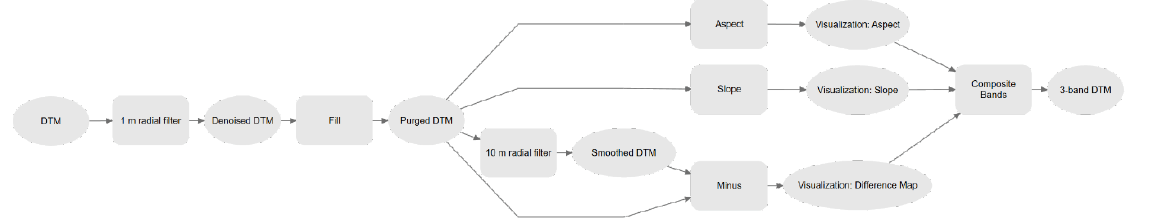
Figure 5. Overview of the DTM generation workflow.